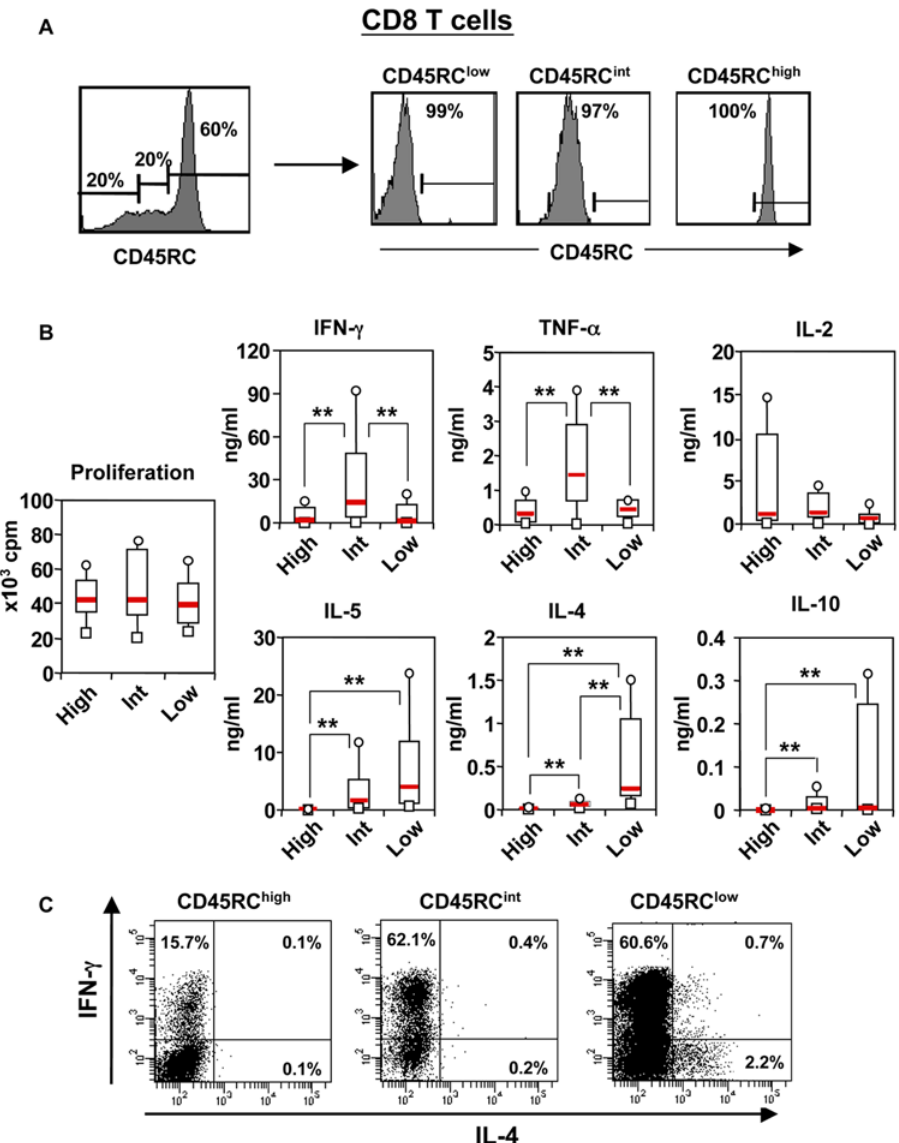
Figure 5. Cytokine profile of human CD45RC CD8 T cell subsets. ( A ) Representative example of the purification of CD45RC high , CD45RC int and CD45RC low CD8 T cell subsets. Results are shown as histograms for CD45RC expression on CD8 T cells before (left histogram) and after CD45RC subsets purification (right histograms). The values within the histograms represent the percentage of CD45RC T cell subsets. ( B ) These sub- populations were stimulated in vitro with anti-CD3 and anti-CD28 mAbs. The supernatants were collected at 96 h of culture and analyzed for the presence of cytokines using the CBA kit and Elisa. The results obtained in 12 healthy individuals are presented as box plot diagrams. The p-values were calculated using the Wilcoxon matched-pairs test; **, p , 0.02. ( C) For intracellular measurement of cytokines, purified CD8 CD45RC T cell subsets were stimulated and analyzed for intracytoplasmic cytokines as indicated in the legend of figure 4. The results are representative of three independent experiments. p , 0.001). (B) Dot plot showing CD45RC and CD45RA expression by CD4 T cells from 2 different donors with different profiles. (C) CD45RChigh and CD45RClow CD4 T cell subsets were purified by flow cytometry. CD45RClow CD4 T cells were stained with anti-CD45RA mAb and separated by flow cytometry into CD45RAhigh and CD45RAlow subsets. (D) These sub- populations as well as total CD45RClow CD4 T cells (white bars) Figure S1 Differential cytokine production by human CD45RA CD45RClow CD4 T cell subsets (A) CD4 T cells from 18 healthy and CD45RChigh CD4 T cells (black bars) were stimulated in controls were stained for the expression for CD45RA and vitro with plate-bound anti-CD3 and soluble anti-CD28 mAbs. CD45RC isoforms. The results are presented as correlation between CD45RAlow and CD45RClow T cells subsets (r = 0.8;